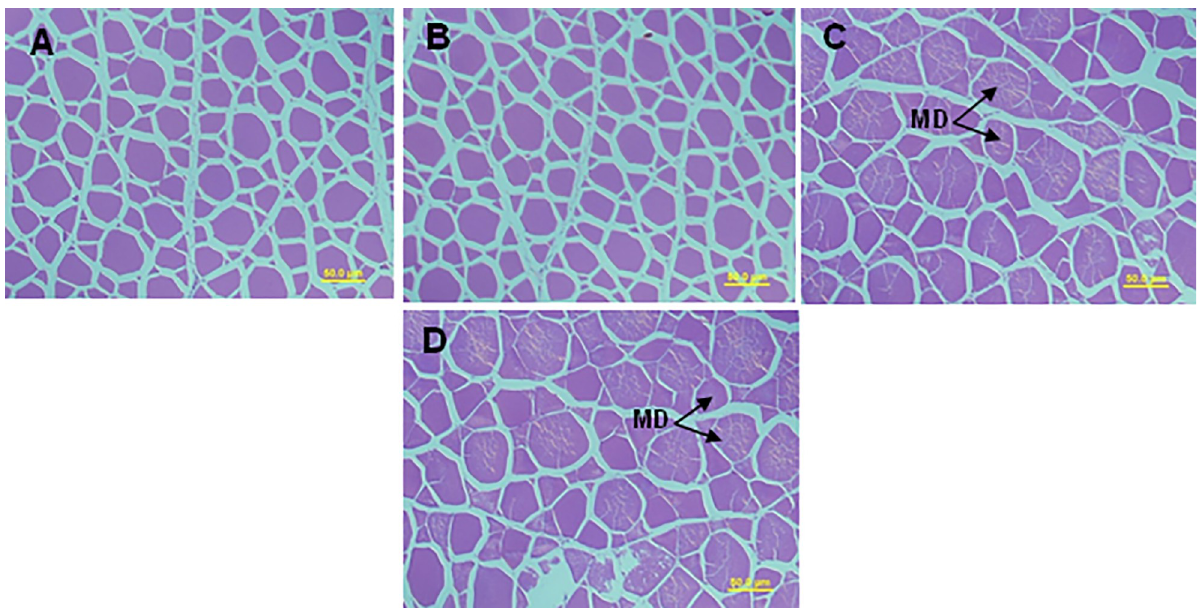
Fig 3. Histological structure of the liver of juvenile barramundi fed control, 60FPM, 60GPM and 60UPM diets (A-D, respectively). Black arrow in muscle micrographs indicates myodigeneration (MD) (H&E staining, 40 x magnification, scalebar = 50 μ m).